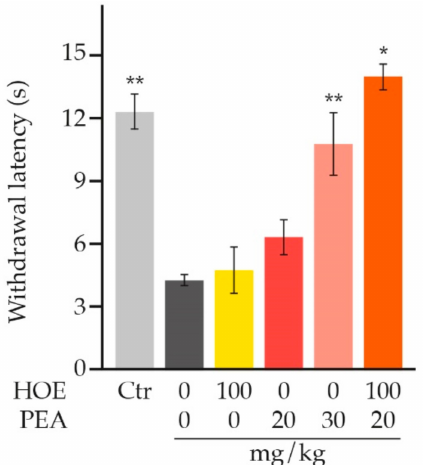
Figure 6. Effects of combining a single sub-optimal oral dose of hemp oil extract (HOE) with PEA on heat hyperalgesia associated with neuropathic pain. Oral administration of PEA (30 mg/kg) significantly relieves heat hyperalgesia, increasing the withdrawal latency to nearly control values (Ctr), while HOE (100 mg/kg) does not exert any effect. The combination of the two compounds at the indicated doses (orange bar) exerts greater-than-additive antinociceptive effects. * p < 0.001 and ** p < 0.0001 vs. chronic constriction injury (dark grey bar). The source data come from Figures 2B, 4D and 6B published in